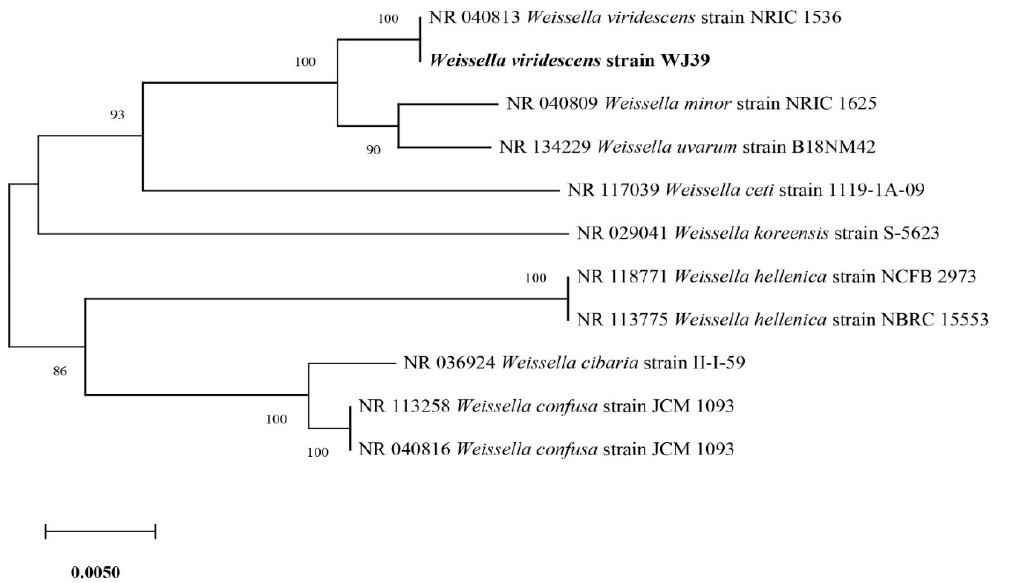
Figure 7. Phylogenetic tree based on the sequencing results of the 16S rRNA genes extracted from the genome shows the close relatives of W. viridescens strain WJ39.